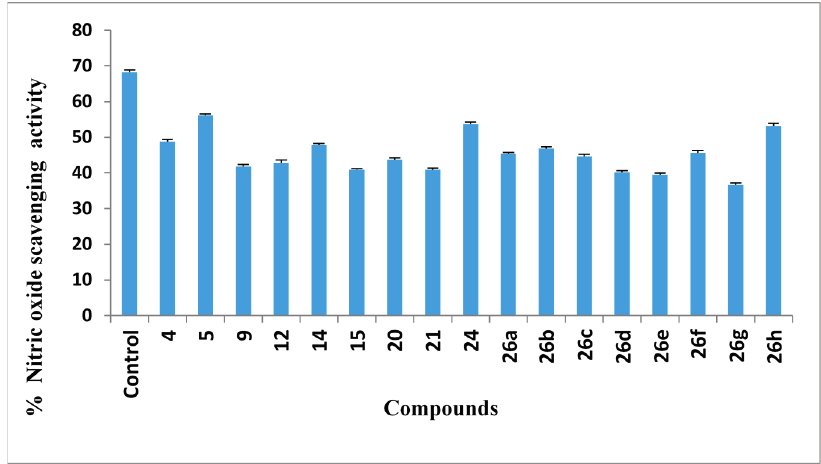
Figure 4. Antioxidant activities of compounds using